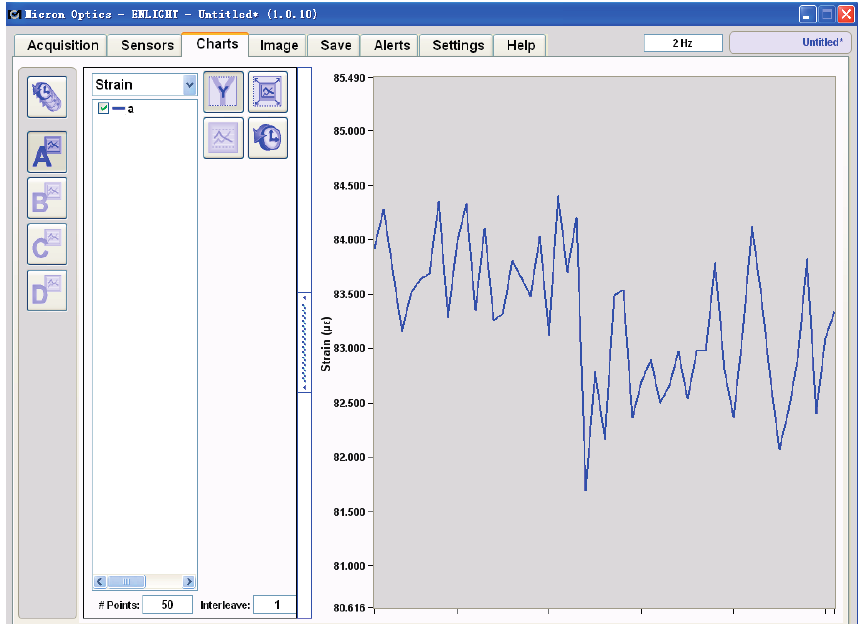
Figure 5. Variation in FBG strain in the unloading